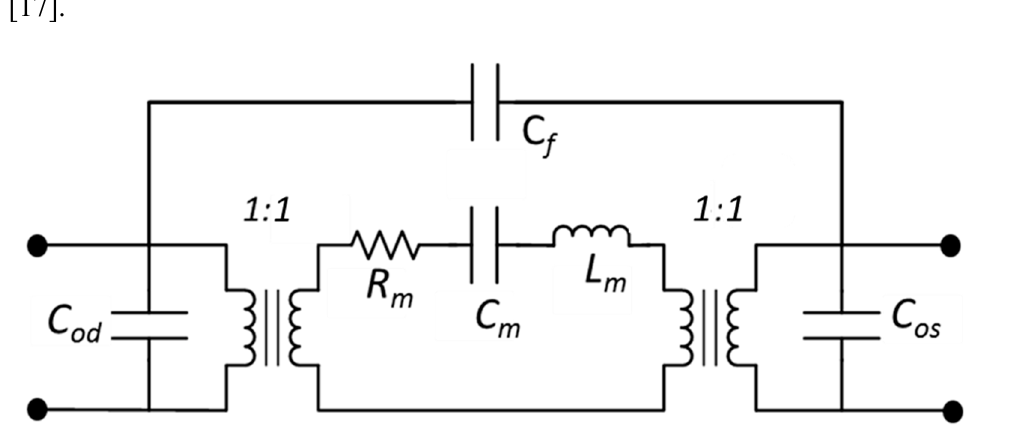
Figure 3. The lumped-element equivalent circuit model of a 2-port ZnO-on-SOI